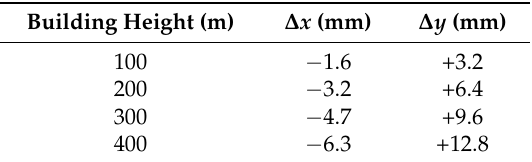
Table 1. Approximations of the systematic bias at different building